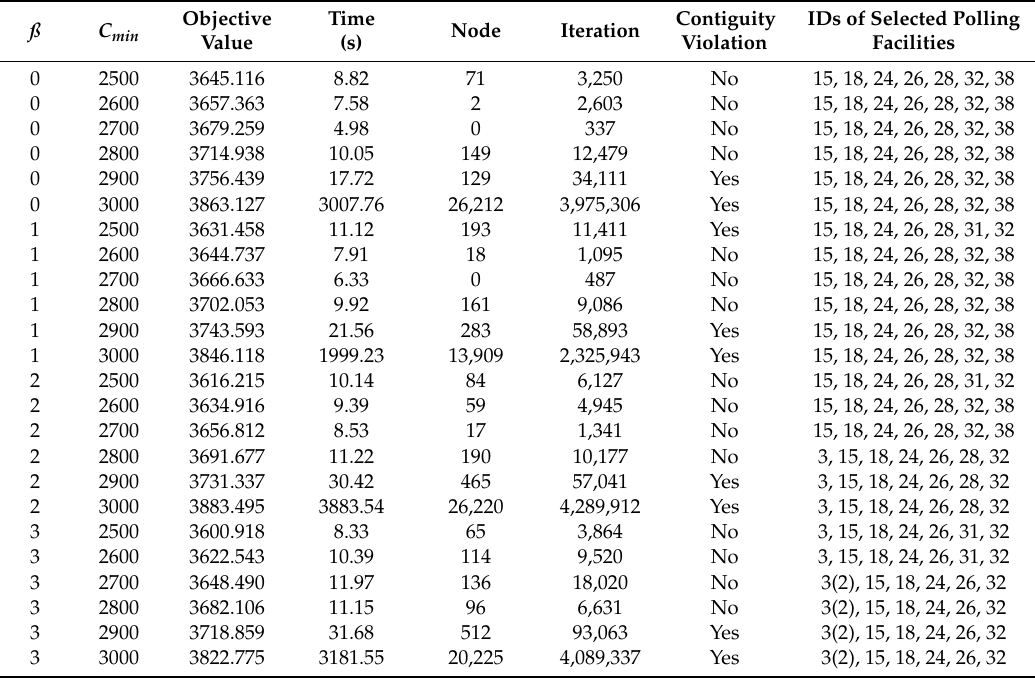
Table 2. Computational results for the large dataset ( n = 200, m = 38, p =